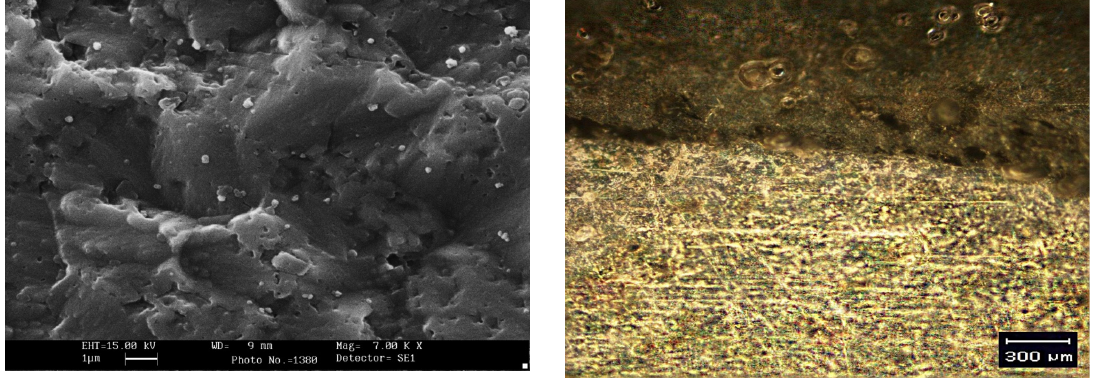
O -free corroded 2 3